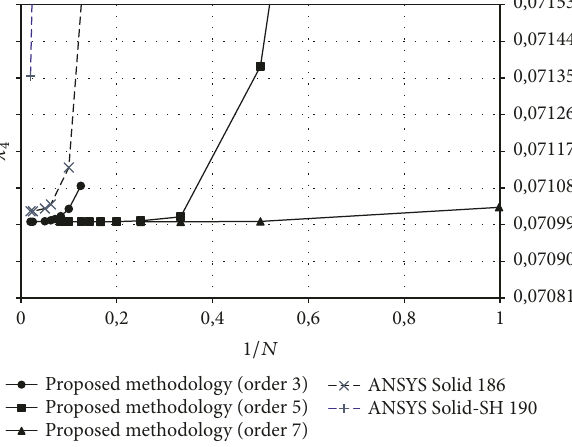
̂𝜆 1/𝑁 ( ℎ -convergence). 3 versus